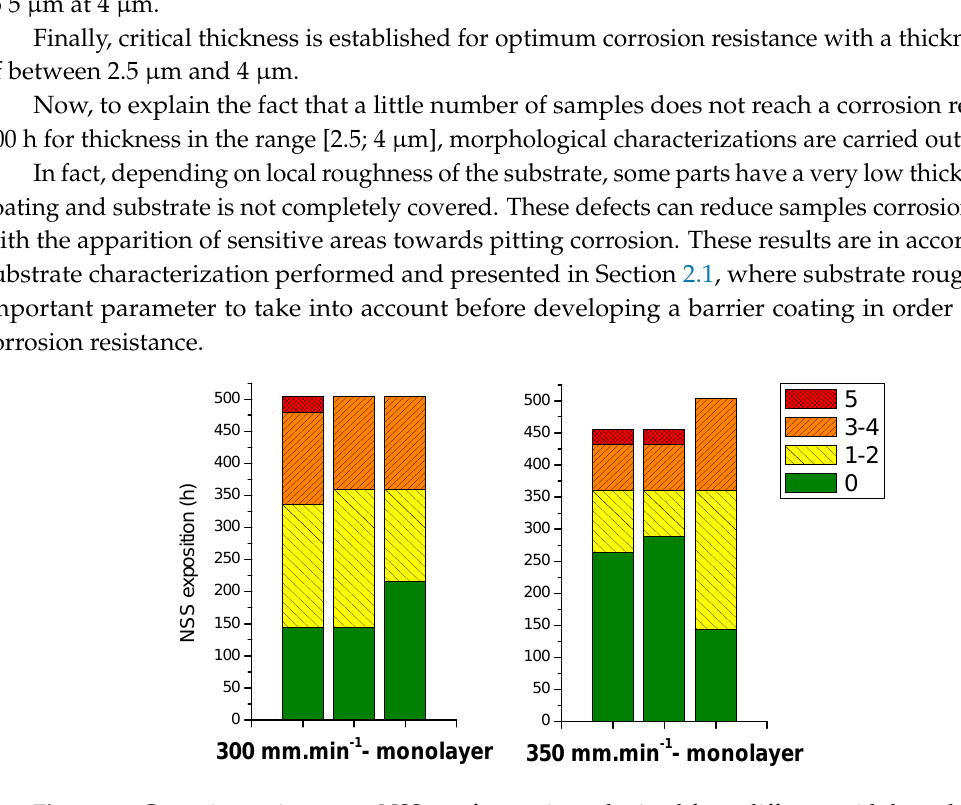
Figure 14. Corrosion resistance to NSS test for coatings obtained from different withdrawal speeds: 300 and 350 mm · min − 1 .